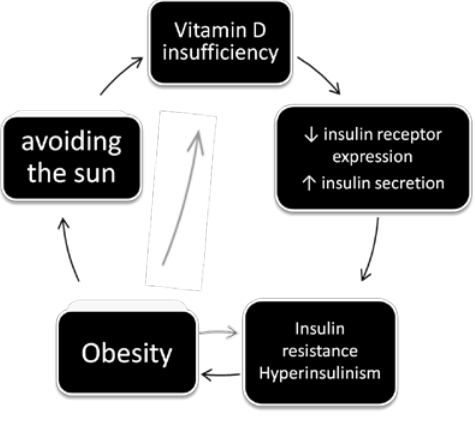
Figure 2. The effects and causes of vitamin D deficiency in women with PCOS (after: Grzechocinska B, Dabrowski FA, Cyganek A, Wielgos M. The role of vitamin D in impaired fertility treatment.